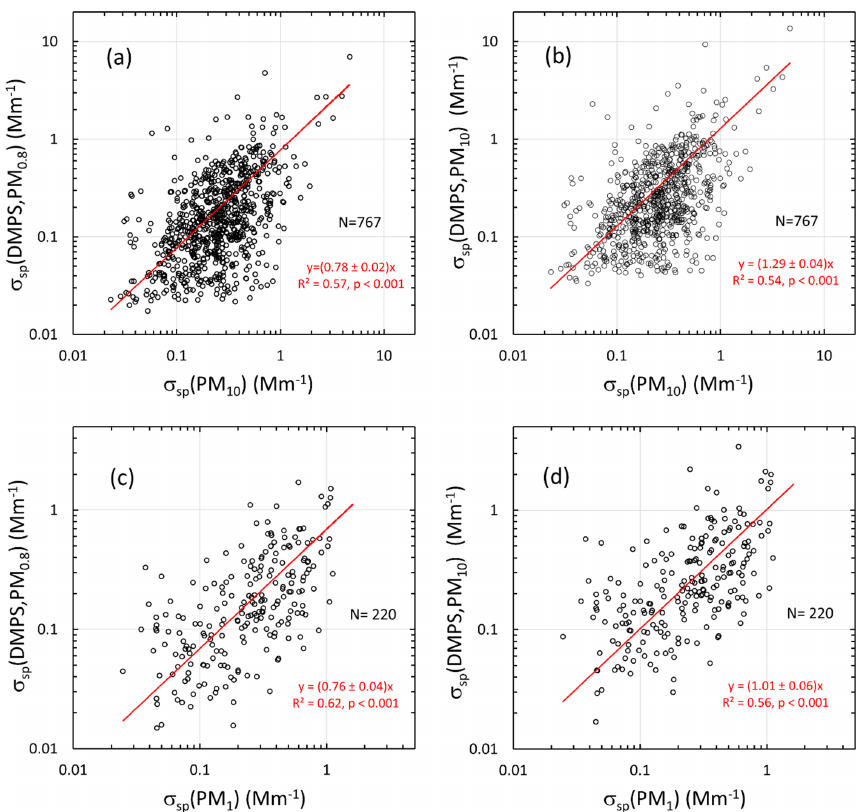
Figure 8. Comparison of scattering coefficients calculated from the DMPS vs. scattering coefficients calculated from the PM 1 and PM 10 filter sample data at Dome C, all at λ = 550nm. The scattering coefficients calculated from the DMPS data were averaged for the sampling times of the PM 1 and PM 10 samples and interpolated to λ = 550nm. (a) Lower estimate of σ sp ( = σ sp (DMPS, PM 0 . 8 )) vs. σ sp (PM 10 ), (b) up- per estimate of σ sp ( = σ sp (DMPS,PM 10 )) vs. σ sp (PM 10 ), (c) σ sp (DMPS, PM 0 . 8 )) vs. σ sp (PM 1 ), and (d) σ sp (DMPS,PM 10 )) vs. σ sp (PM 1 ). N : number of data points. The red line shows the linear regression line that is forced through zero. The regression equations show the slope ± standard error of the slope, the squared correlation coefficient, and the p value of the